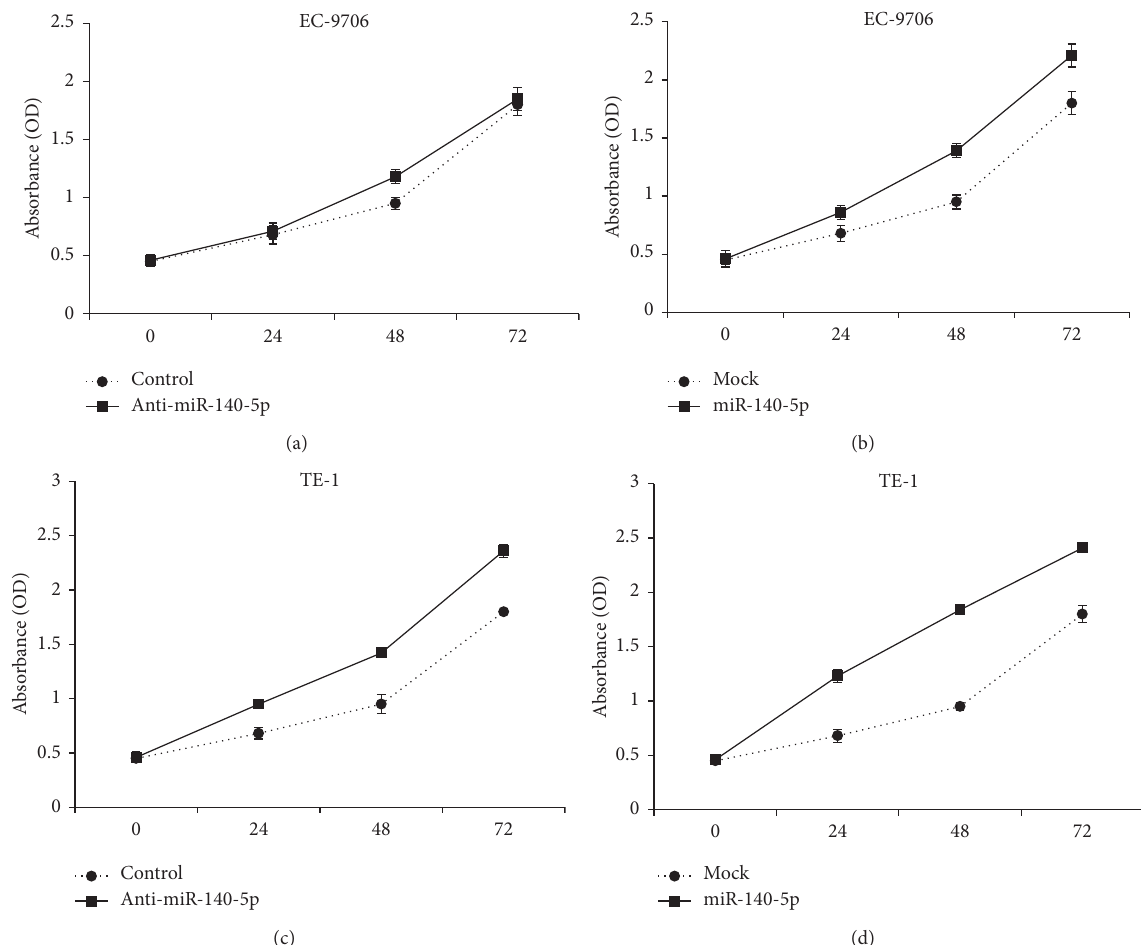
Figure 3: Effect of miR-140-5p on cell proliferation of esophageal cancer cells. Cell proliferation of EC9706 (a and b) and TE-1 (c and d) was analyzed after transfection with miR-140-5p and anti-miR-140-5p. The cells were exposed to respective mRNA sequence and incubated for 24, 48, and 72 h and growth inhibition was evaluated using the MTT